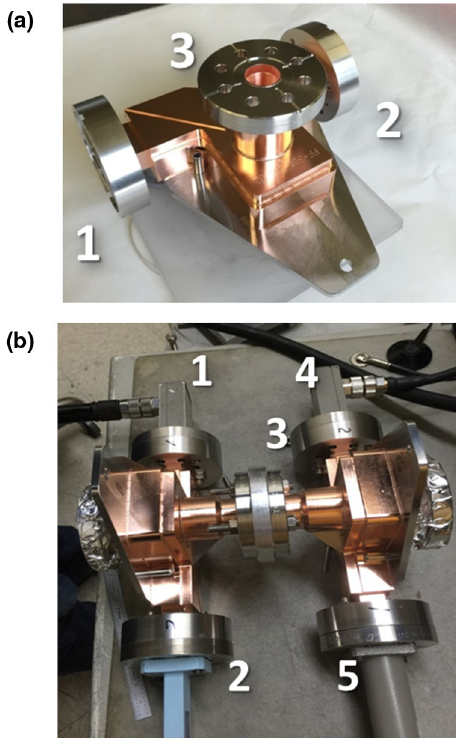
FIG. 10. (a) Photograph of the rf polarizer with no attachments, and (b) photograph of two rf polarizers connected via the cylindrical